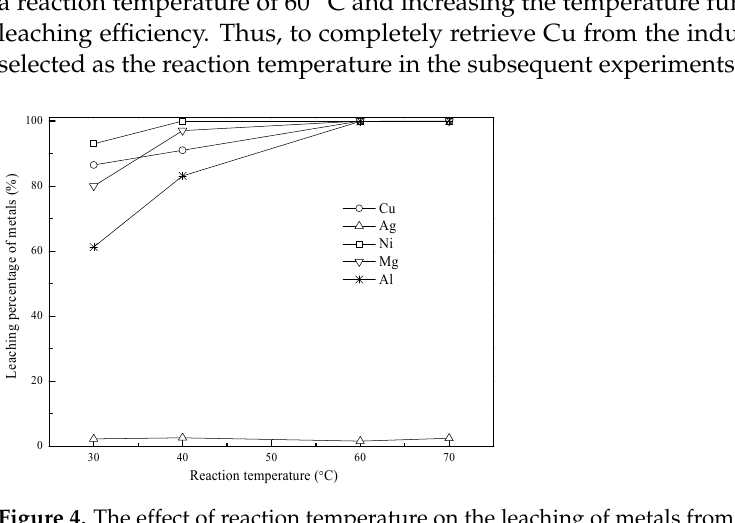
Figure 4. The effect of reaction temperature on the leaching of metals from the industrial